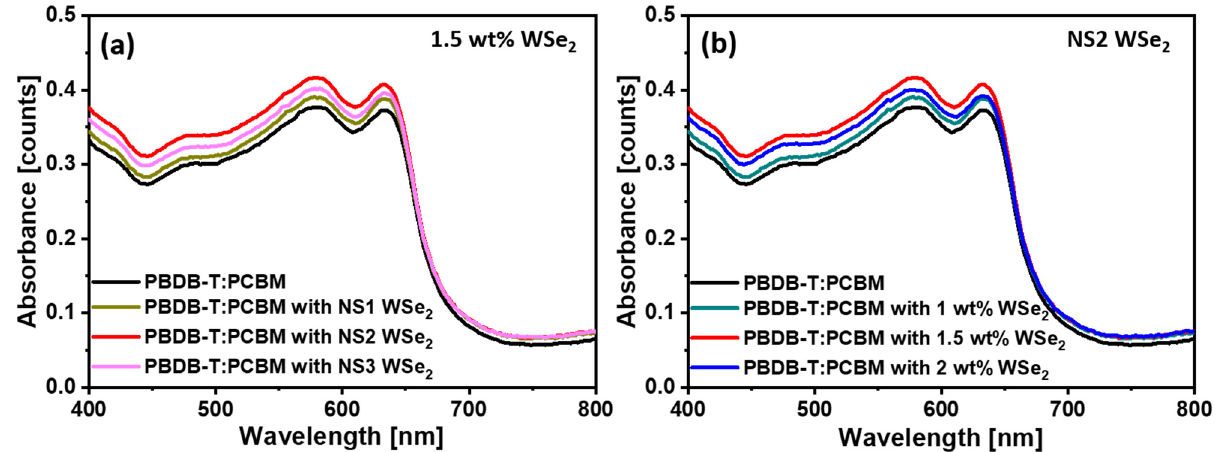
Figure 4. ( a ) UV–vis absorption spectra of pure and NS1–NS3 WSe 2 NSs blended PBDB-T:PCBM film; ( b ) UV–vis absorption spectra of pure and different concentrations of NS2 WSe 2 blended PBDB-T:PCBM film.